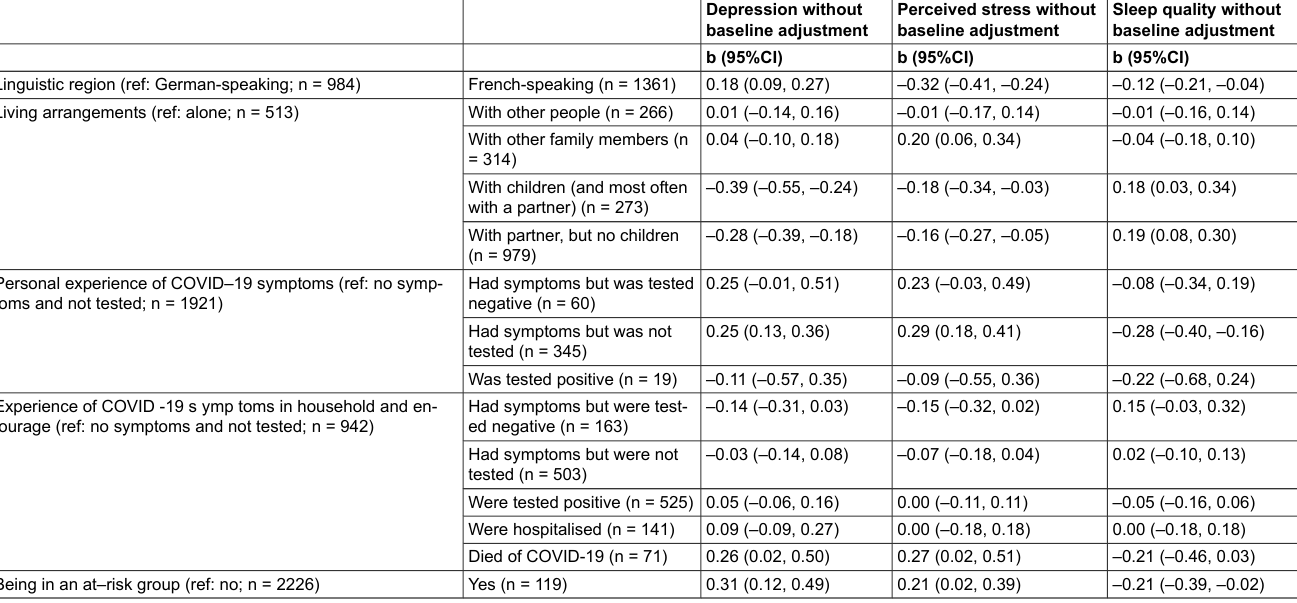
Table S1: Associations of the psychological consequences of the COVID-19 crisis without mention of it as a cause with linguistic region, living arrangements, experiencing COVID-19 symptoms and being in an at-risk group, without baseline adjustment.